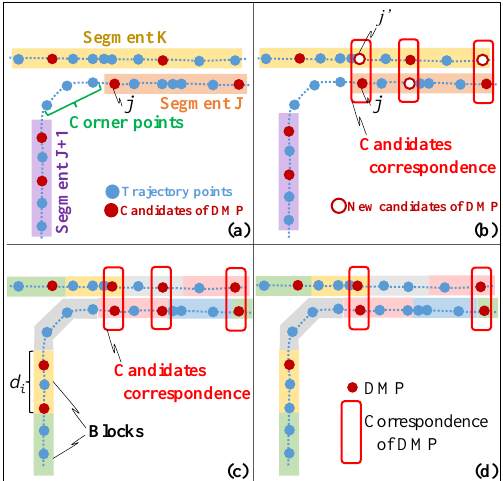
Figure 3. Determination of DMP and correspondences detection